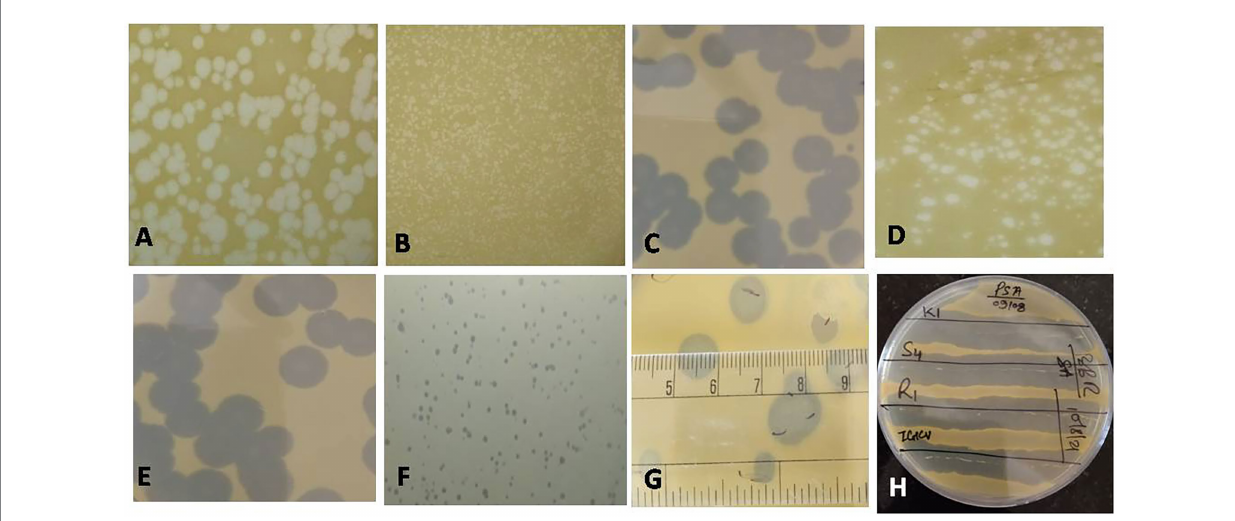
FIGURE 2 Plaques of different phages measuring between 1 and 10 mm in size ( A : NR16; B : NR08; C : NR13; D : NR02; E : NR10; F : NR09; G : NR11); (H) Clearance of growth around phage streaked lines on Xoo -inoculated soft agar plates for host